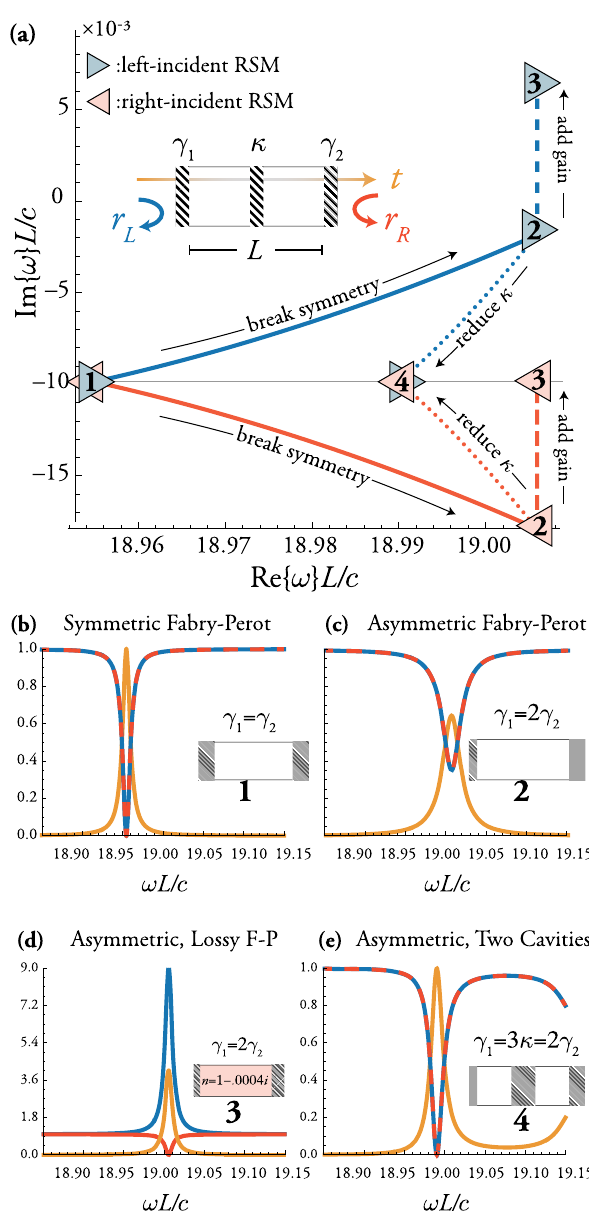
Figure 3: Illustration of reflectionless scattering modes (RSMs) and R-zero spectrum for simple two- and three-mirror resonators of , γ − 1 length L in 1D, consisting of δ -function mirrors of strengths γ − 1 , 1 2 and κ − 1 , as indicated in the schematic in (a). Throughout, we fi x γ ≡ c / L . Blue and red lines 1 → 2 indicate the effect of breaking 2 → 2 γ symmetrybyvarying γ from γ .AbidirectionalRSM[asin(b)] 1 2 2 splits into two complex conjugate R-zeros off the real axis and a re fl ectionless steady-state (RSM) no longer exists, as in (c). Adding gain to the cavity, indicated by blue and red lines 2 → 3, brings the lowerR-zeroto thereal axis(butnottheupperone),creatinga right- incident amplifying RSM, as in (d). Alternatively, adding a middle / 3 is suf fi cient to bring both mirror and reducing its κ from ∞ → 2 γ 2 R-zerosbacktotherealaxis(2 → 4in(a)),creatingsimultaneousleft and right RSMs at a different frequency from the symmetric Fabry – Pérot (FP) resonator (see (e)), without restoring parity